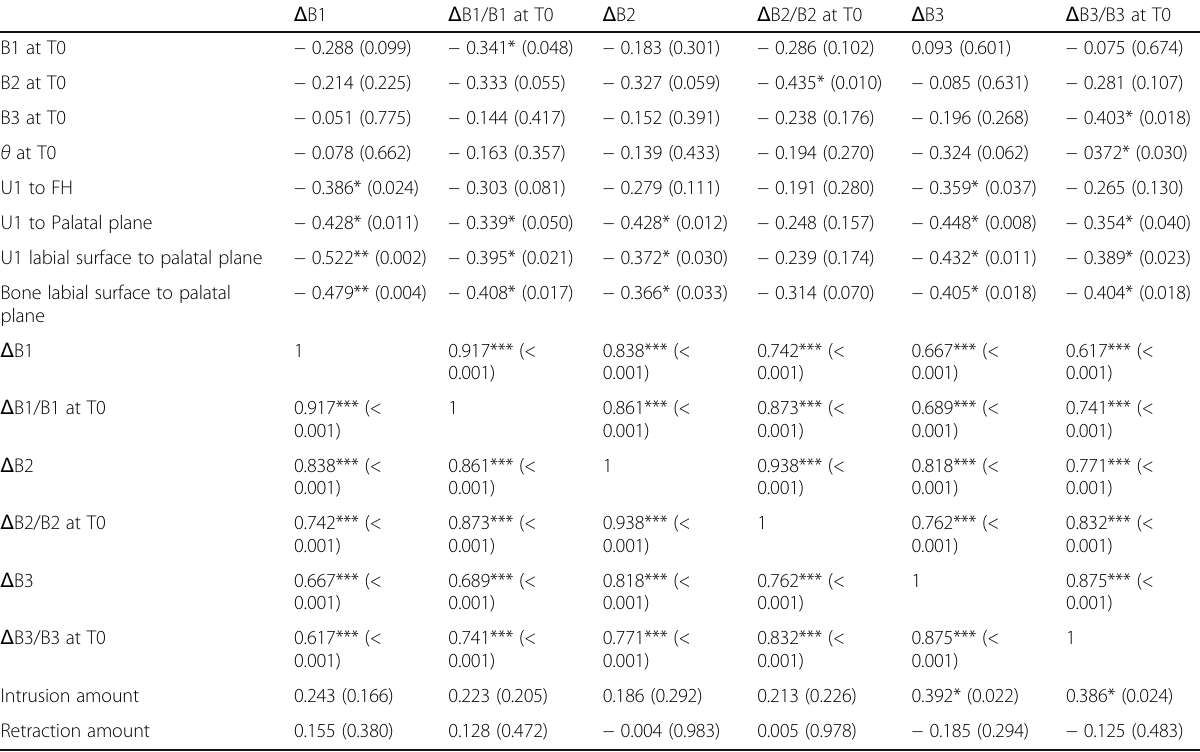
Table 2 Correlation between mean changes of bone thickness and potential influencing factors; r value ( P value)